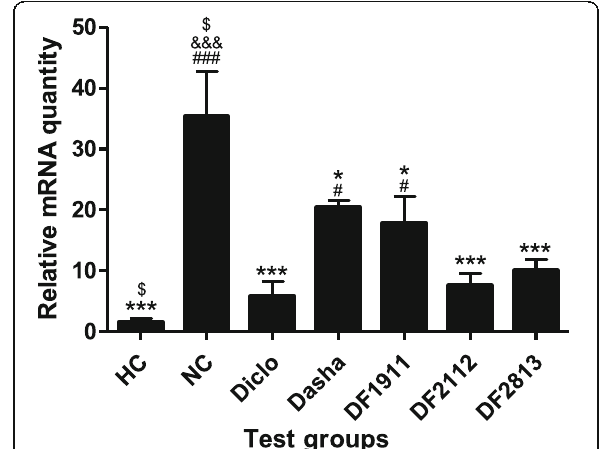
Fig. 6 Effect of formulations on the mRNA expression of TNF- α in inflamed paw tissue. HC: Healthy control, NC: Negative control, Diclo: Diclofenac sodium, Dasha: Dashamoola Kwatha , DF: Dashamoola Formulation. Values are expressed as Mean ± SEM ( n = 3). Comparisons were done between NC/HC and each individual treated group by Dunnett ’ s multiple comparison test. ### = p < 0.001 when compared to HC; * = p < 0.05, *** = p < 0.001 when compared to NC; &&& = p < 0.001 when compared to Diclo; $ = p < 0.05 when compared to